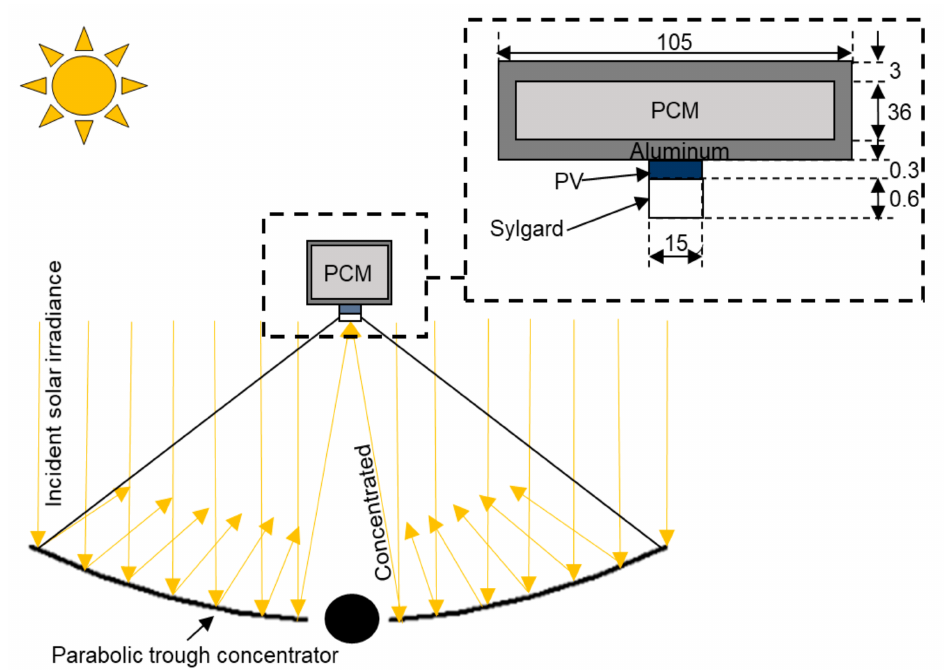
Figure 1. Physical schematic of CPVPCM system (not to